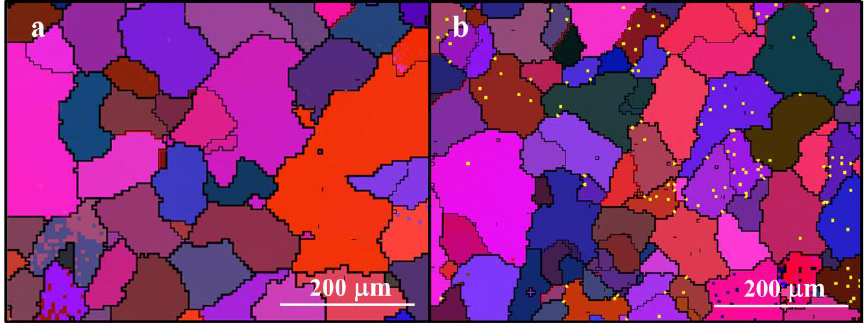
Figure 9. EBSD images of 7075 T6 Al alloy without ( a ) and with 0.1 wt. % Sr additions ( b ) (yellow dots in the image are set as Al 4 Sr).